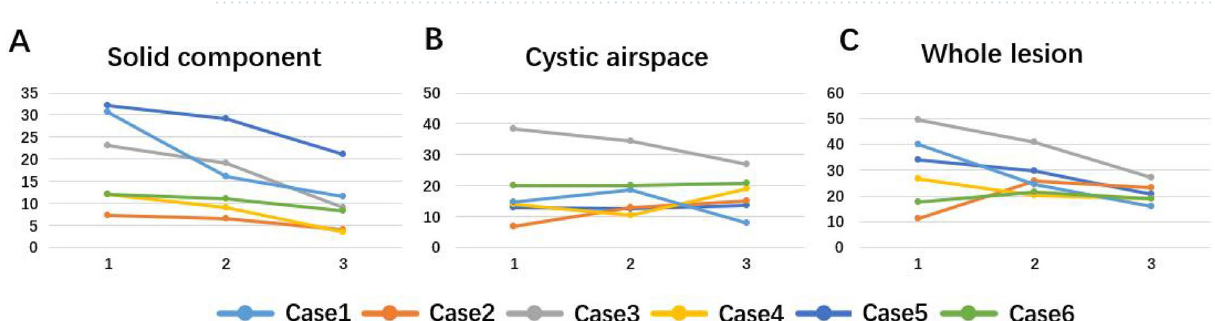
Figure 2. A 59-year-old male with lung cancer associated with cystic airspace (SSC). The lesion was located in the upper lobe of the right lung. ( A ) Axial-baseline CT imaging (January 21, 2020) showed solid-component and cystic-airspace components (type II). ( B ) The diameter of the solid component showed a significant decrease at the first examination during NC (April 24, 2020), while the cystic component was slightly enlarged. ( C ) The solid component continually decreased, and the lesion mainly manifested the cystic-airspace component at the last examination after NC (May 13, 2020).